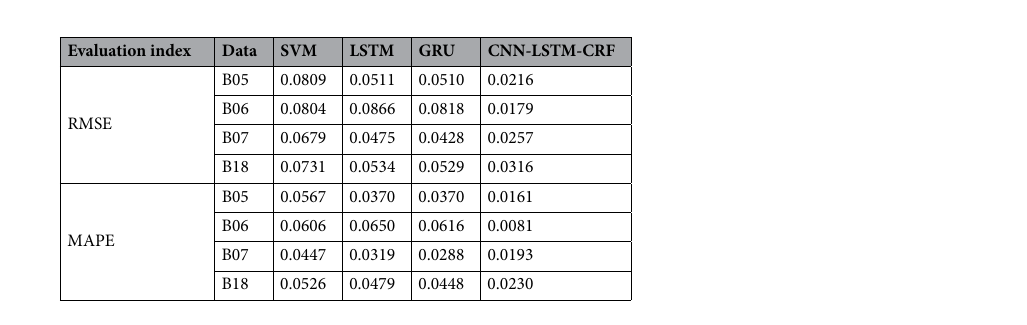
Table 6. Comparison of prediction results of 4